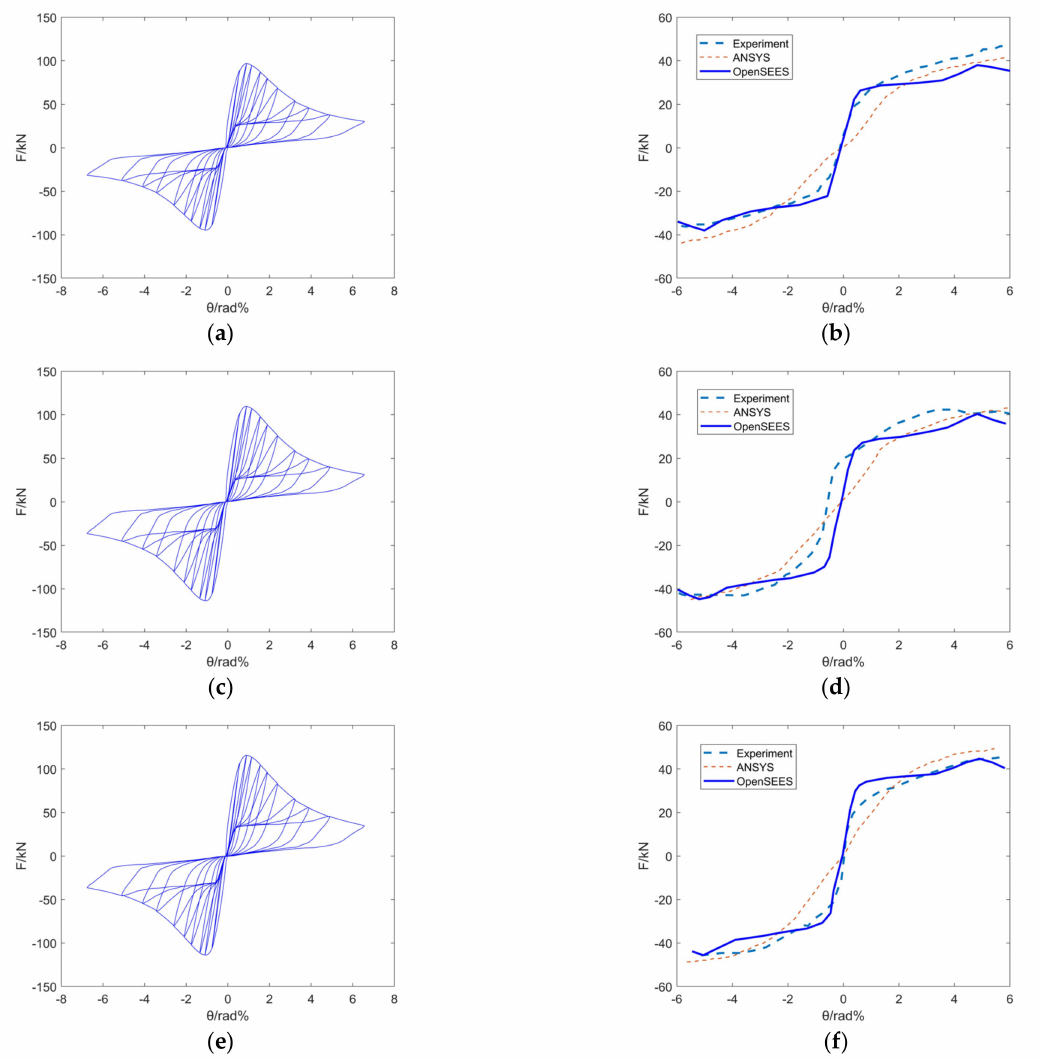
Figure 7. Analysis results of specimens from [27]: ( a ) simulated hysteresis curve of CP1 specimen; ( b ) experimental- numerical comparison for curves of CP1 specimen; ( c ) simulated hysteresis curve of AP1 specimen; ( d ) experimental- numerical comparison for curves of AP1 specimen; ( e ) simulated hysteresis curve of DP1 specimen; ( f ) experimental- numerical comparison for curves of DP1